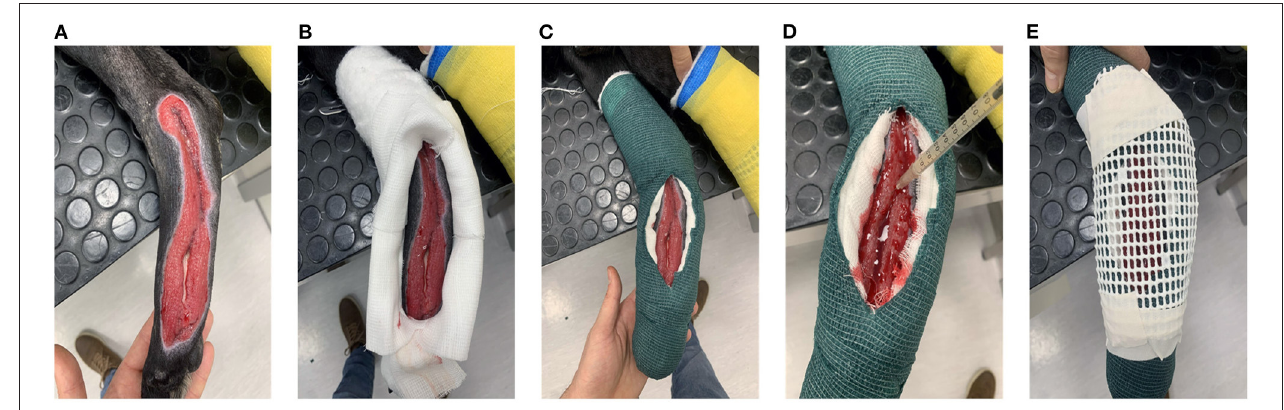
FIGURE 1 | PRP application and bandage at the right tarsal and metatarsal regions in the hind limb of case 1. (A) Healthy and clean wound; (B) Window through the layers of cotton; (C) Dressing fixation with vetrap; (D) PRP application; (E) Thermoplastic mesh